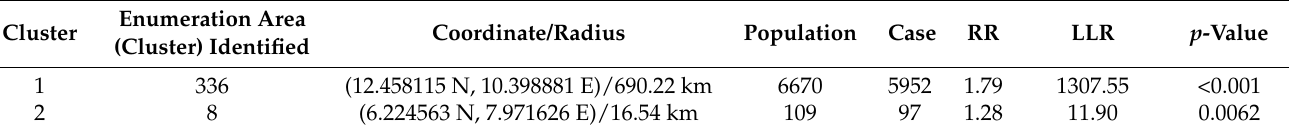
Figure 3. Interpolation of incomplete ANC visits in Nigeria, 2018. Table 2. SaTScan analysis result summary table for incomplete ANC